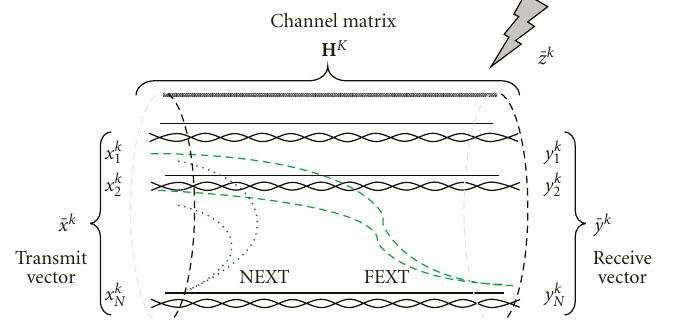
Figure 1: Illustration of DMT transmission and occurring NEXT and FEXT interference on a copper access binder. standardized channel models, which are typically based on statistics and reflect a worst-case scenario [1, 22,